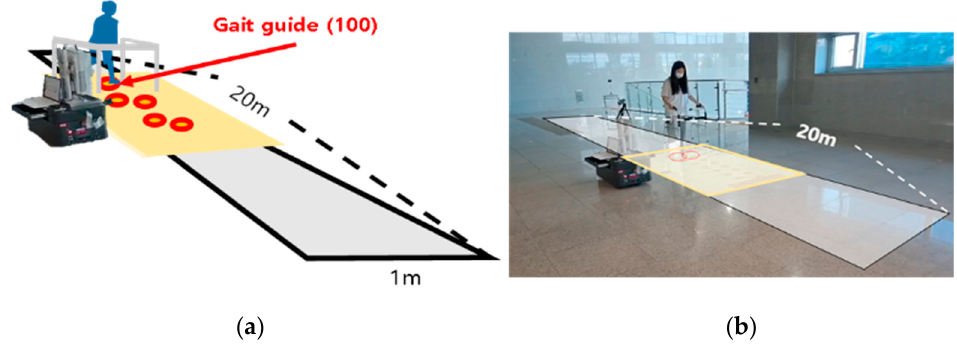
Figure 7. Experimental Environment: ( a ) concept of experiment; ( b ) a photograph of experiment.